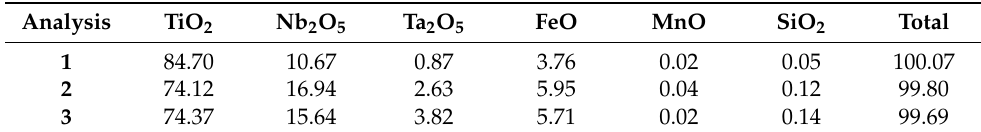
Table 3. Chemical composition of Nb-Ta-rich rutile as determined by SEM/energy-dispersive spectrometry (EDS) (for position, see Figure 6a.)